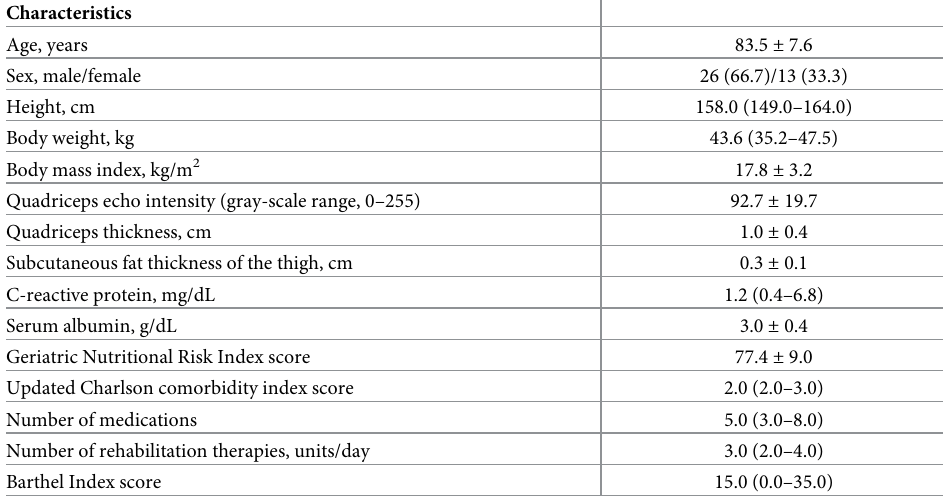
Table 1. Characteristics of participants at